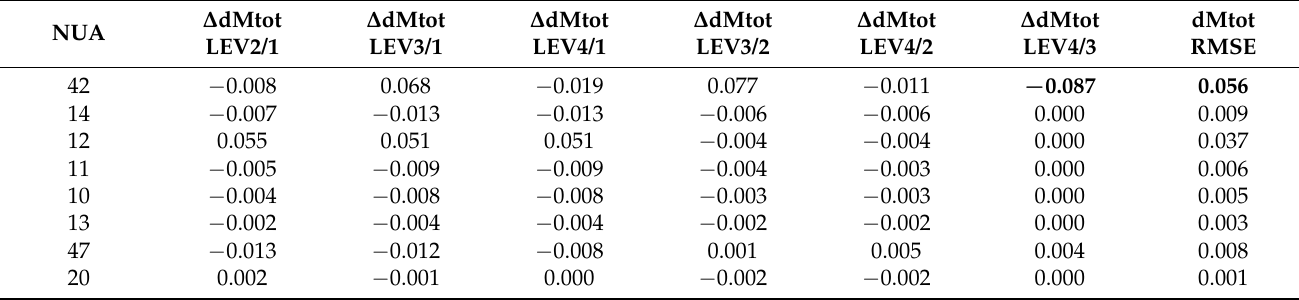
Table 4. Higher NUA assessment variations in real units (>|0.004| for dMtot) among scenarios. Bold numbers represent maximum absolute values.